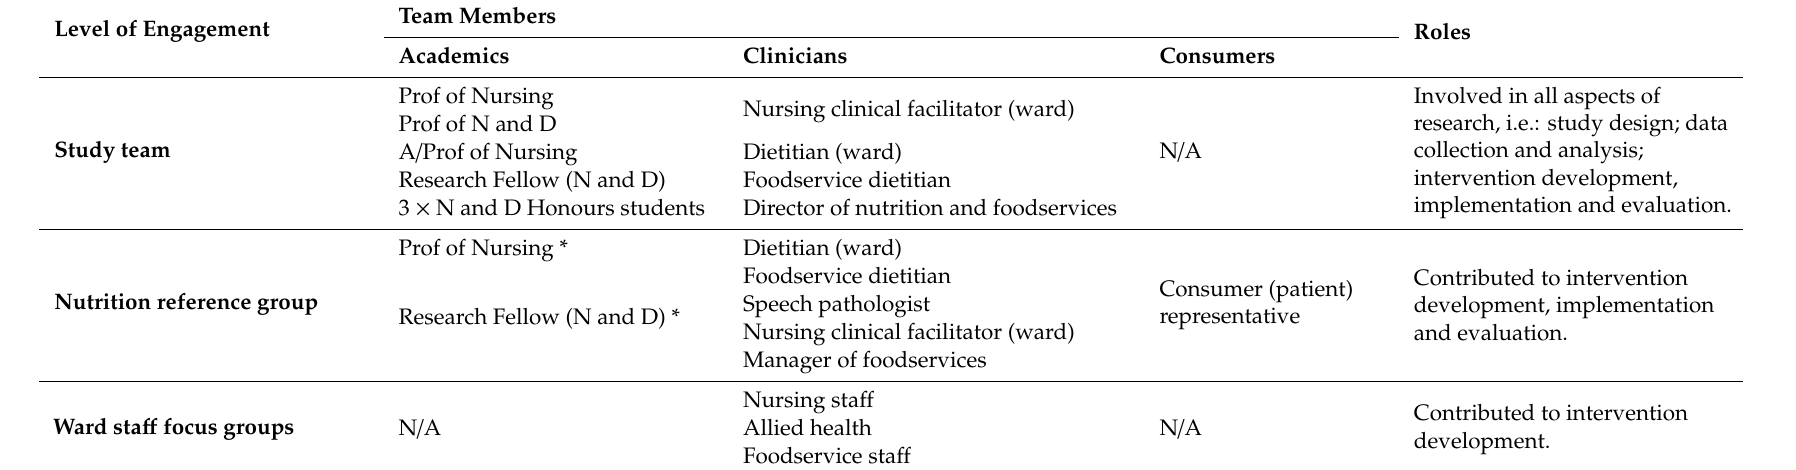
Table 1. Engagement of knowledge